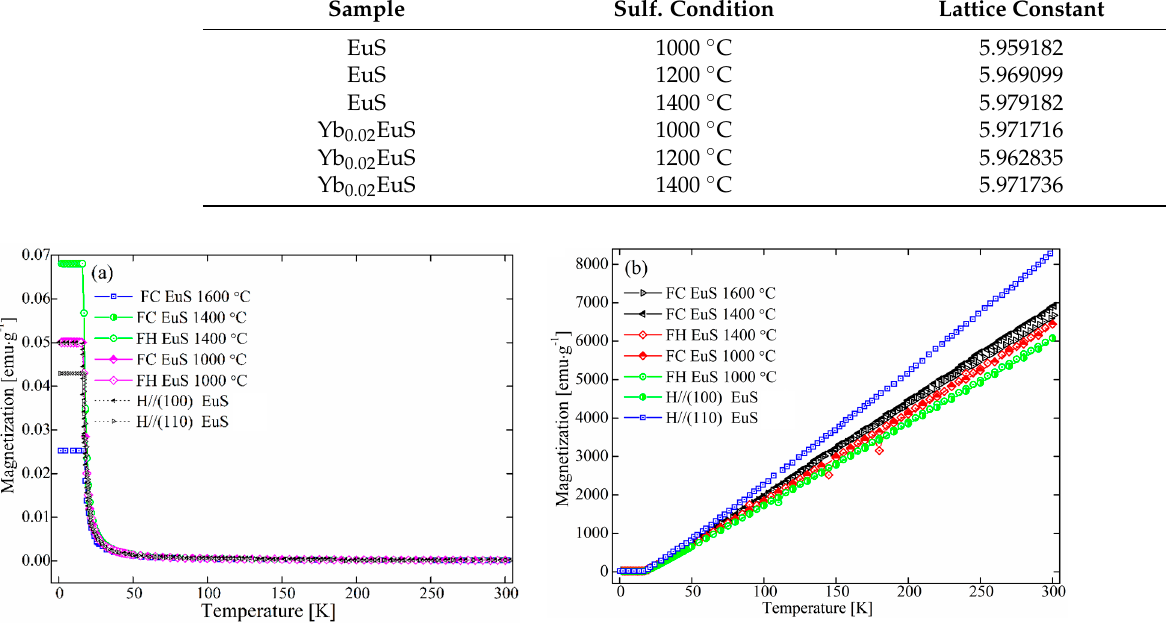
Figure 3. Magnetization of polycrystalline undoped EuS ( a ) and Yb-doped EuS ( b ) as a function of the field. 2.2. Magnetizations of EuS and Yb-Doped EuS Bulks The temperature dependences of magnetization M(T) for sintered polycrystalline EuS bulks were measured under a 100-Oe magnetic field and the magnetic data of sin- gle-crystal EuS along (100) and (110) directions [13] were added for comparison as shown in Figure 2. Temperature-dependent magnetizations were examined in cooling (FC) and heating (FH) states under the presence of an applied magnetic field. Figure 2 shows that all sintered polycrystalline EuS compacts had almost the same FC and FH curves throughout the entire temperature range. There were weaker or smaller tempera- ture-dependent irreversibilities and magnetic asymmetries. The paramagnetic to ferro- magnetic transition for polycrystalline EuS occurred at 18.2 K. Table 2 lists the magnetization at 2 K, Curie temperature (T c ), and Curie parameters of EuS sintered at temperatures in the 1000–1600 °C range. The sintering temperature had an effect on the magnetization at low temperatures. The EuS sintered at 1400 °C had the maximum magnetization value. The polycrystalline EuS prepared by spark plasma sin- tering had a similar magnetization value as the reported single-crystal EuS [13]. The magnetization of EuS sintered at 1600 °C was the lowest. The main factors that affected magnetization were the grain size and impurity content of the EuS. At temperatures above the T c , the inverse susceptibility curve, 1/ χ , was linear and conformed to the modified Curie–Wiess law, χ (T) = χ 0 + C/(T − θ p ), where C stands for the Curie constant, θ p represents the paramagnetic Curie temperature, and χ 0 is the temper- ature-independent term. The M(T) function follows the Curie–Weiss law, and the calcu- lations of the paramagnetic Curie temperature θ P also showed this.